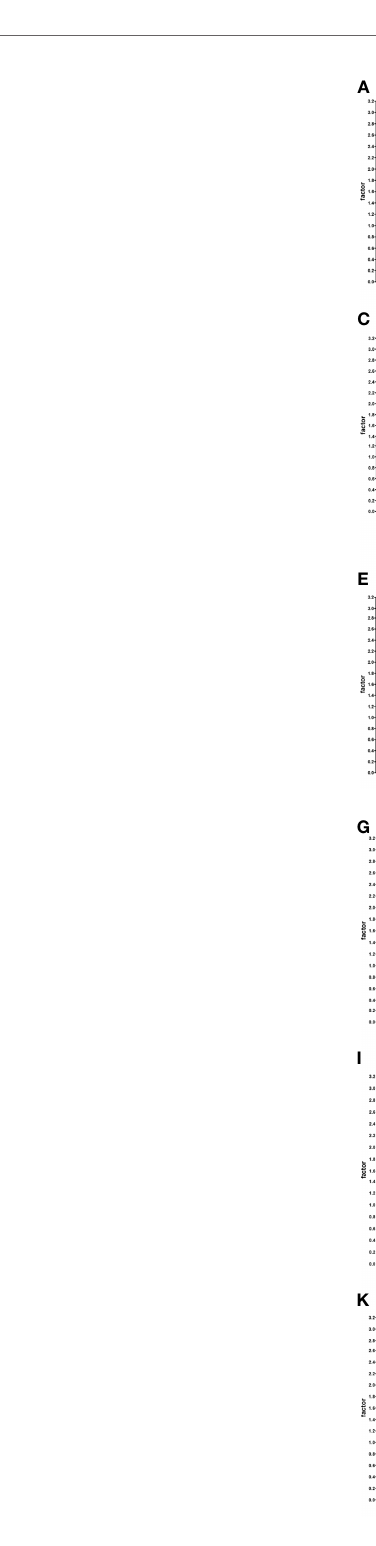
FIGURE 2 | Reactivity of functional anti-AT 1 R antibodies in SSc patients comparing patients with lcSSc and dcSSc (A) , different numbers of organ manifestations (B) , patients with and without skin manifestations (C) , calcinosis (D) , digital ulcers (E) , myositis (F) , lung manifestations (G) , pulmonary arterial hypertension (PAH) (H) , heart manifestation (I) esophageal manifestation (J) , and sicca-syndrome (K) . Individual values are given re fl ecting a factor calculated with the mean of healthy individuals. The grey zone indicates the normal range; n.s., not signi fi cant; -